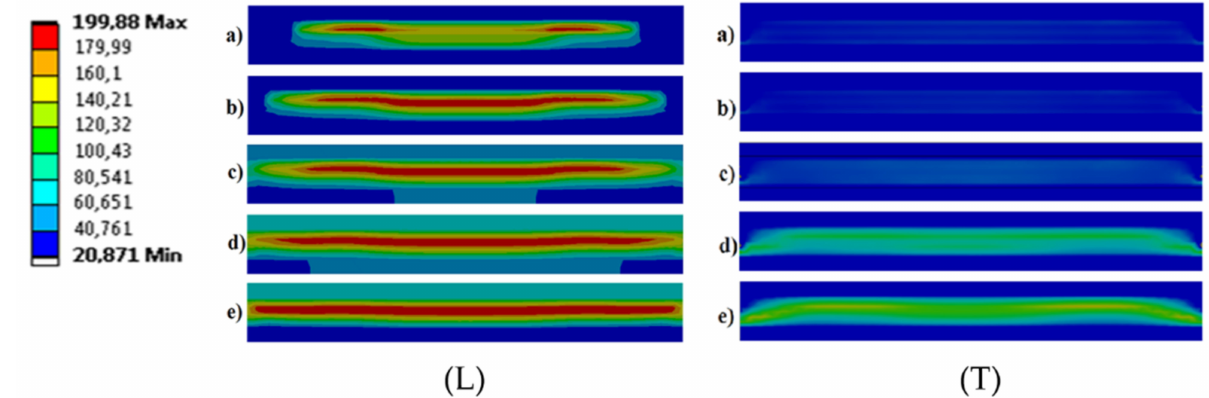
Figure 12. The results of the temperature distribution during ultrasonic heating of the polymer core: ( L ) longitudinal vibration, ( T ) transverse vibration; (a) ta = 10 ms, (b) tb = 25 ms, (c) tc = 50 ms, (d) td = 125 ms, (e) te = 250 ms.